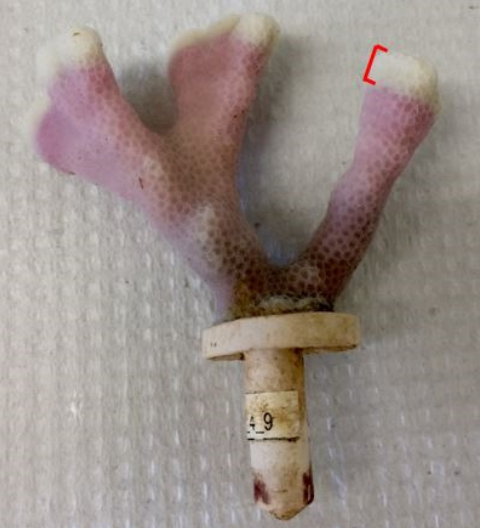
Figure 2. A stained P. compressa nubbin’s exposed skeleton. Linear extension was measured from the stain to the white growth tip. Picture credit: Kelsey Archer